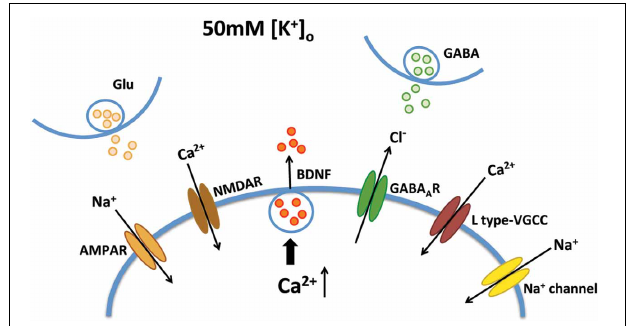
FIGURE 5 | Mechanisms of Ca 2 + -dependent BDNF release during KCl-induced depolarization. KCl-induced BDNF secretion depends on Ca 2 + influx, which can be mediated by L type-VGCC, AMPA receptors, NMDA receptors, GABA A receptors and voltage-sensitive Na +